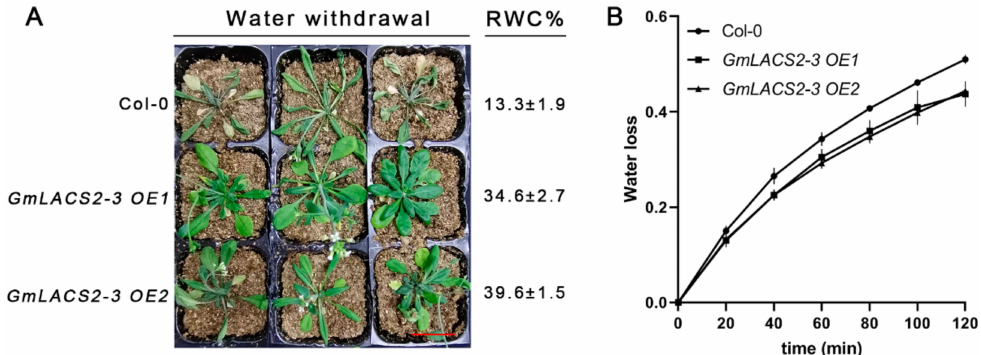
Figure 8. Wilting and drought resistance evaluation in Arabidopsis wild-type Col-0, GmLACS2-3 OE1, and GmLACS2-3 OE2 . ( A ) The appearance of plants after 2 weeks withdrawal of water and RWC percentage. Scale bar = 3 cm. ( B ) Water loss rate of Col-0, GmLACS2-3 OE1, and GmLACS2-3 OE2 . The values shown are means ± SD ( n = 6), p <